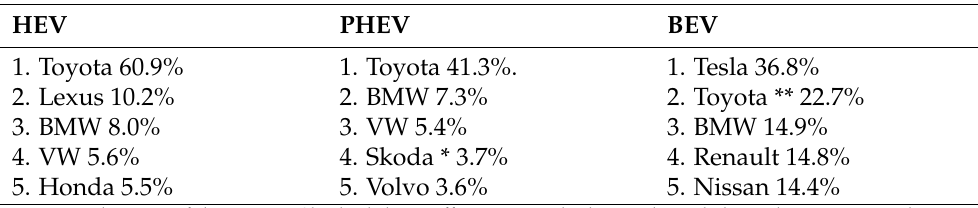
Table 3. Recognition of AFV brands (the five most